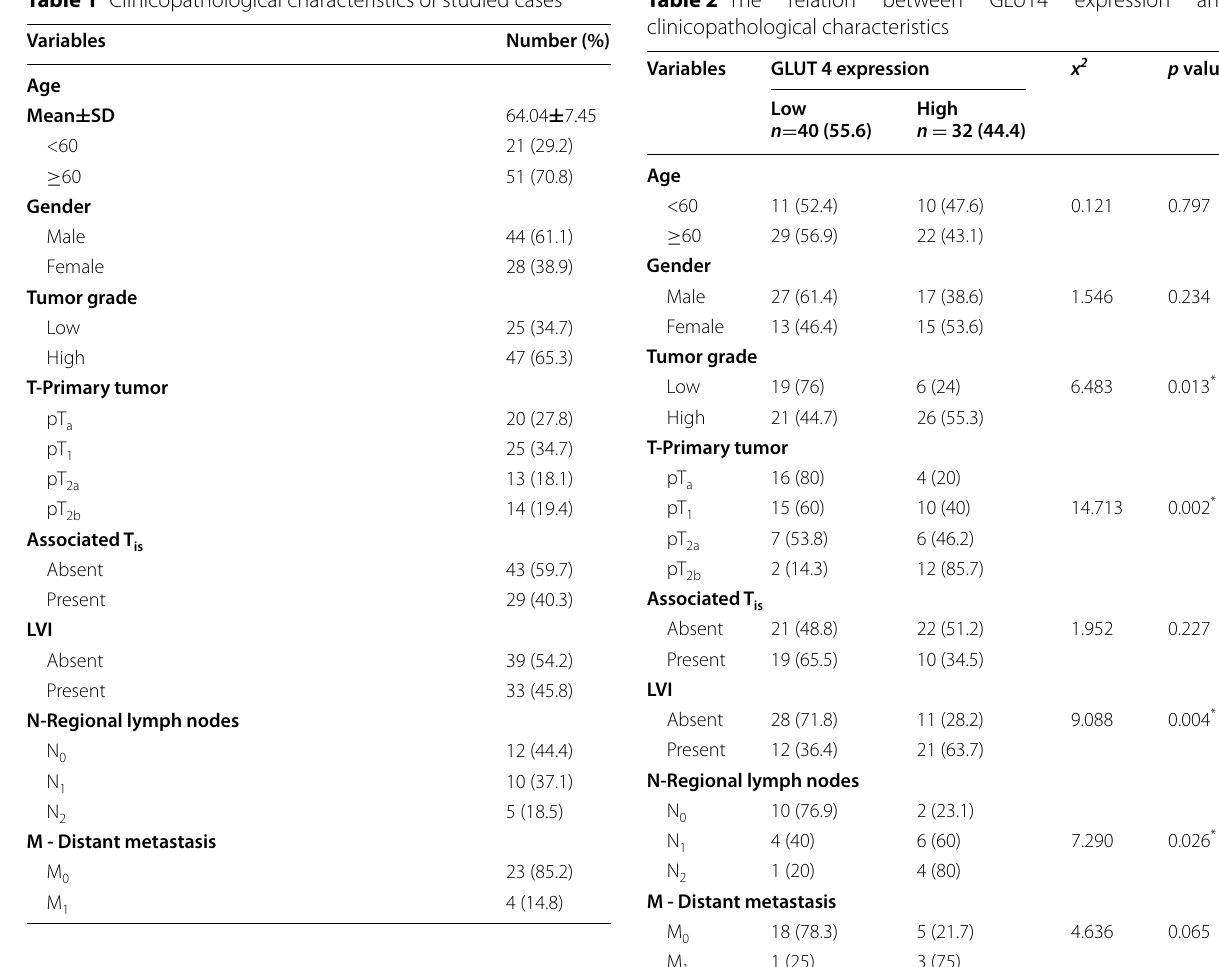
Table 2 The relation between GLUT4 expression